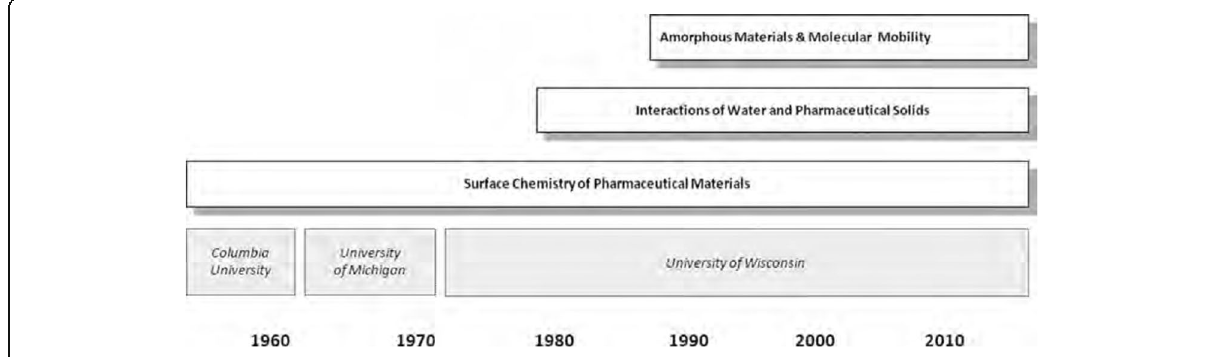
Fig. 1 A brief timeline of Professor Zografi ’ s research (adapted from Taylor and Hancock